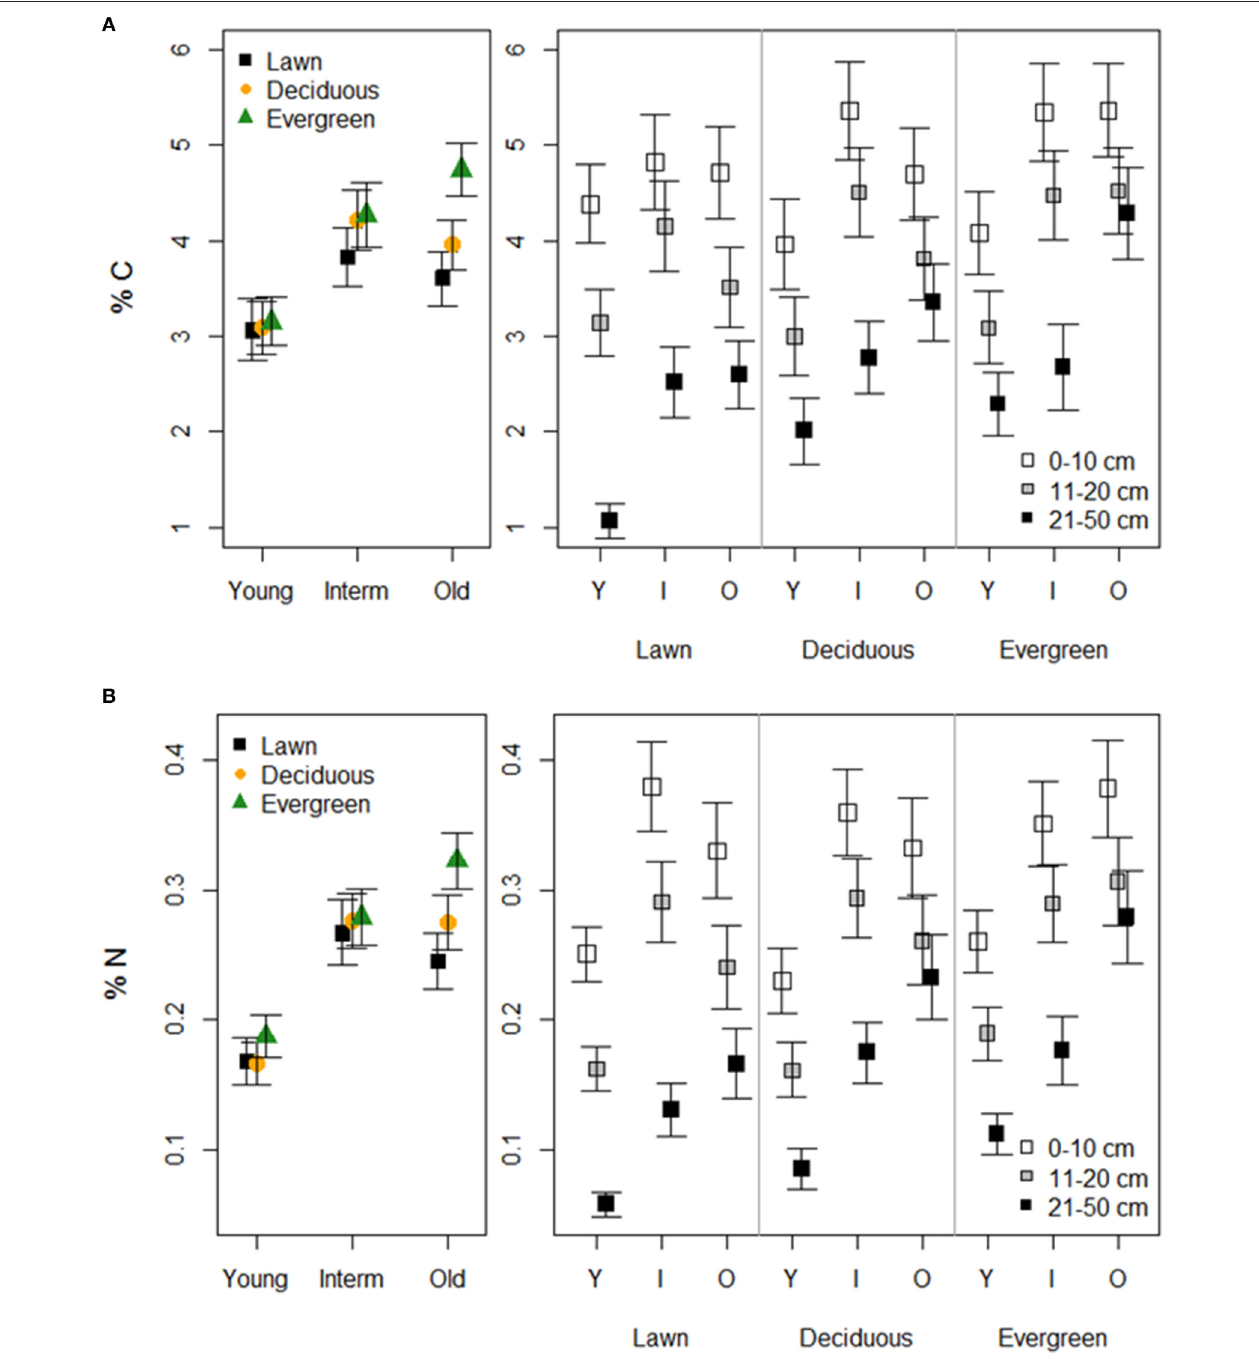
FIGURE 3 | The effects of plant functional groups and park age on soil tot-carbon (A) and tot-nitrogen (B) concentrations. Predicted means ± SE values are presented. Panels on the left present data with the three depth intervals pooled, while panels on the right show results for each depth interval separately.